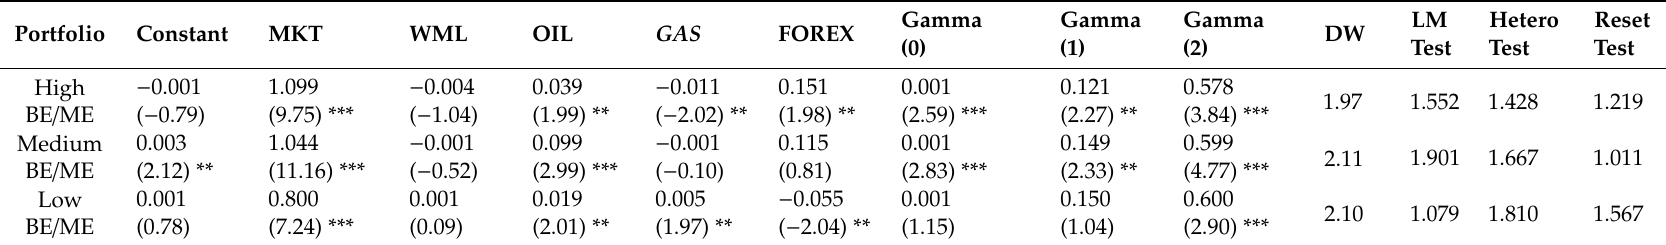
Table 4. Results for book-to-market value-based